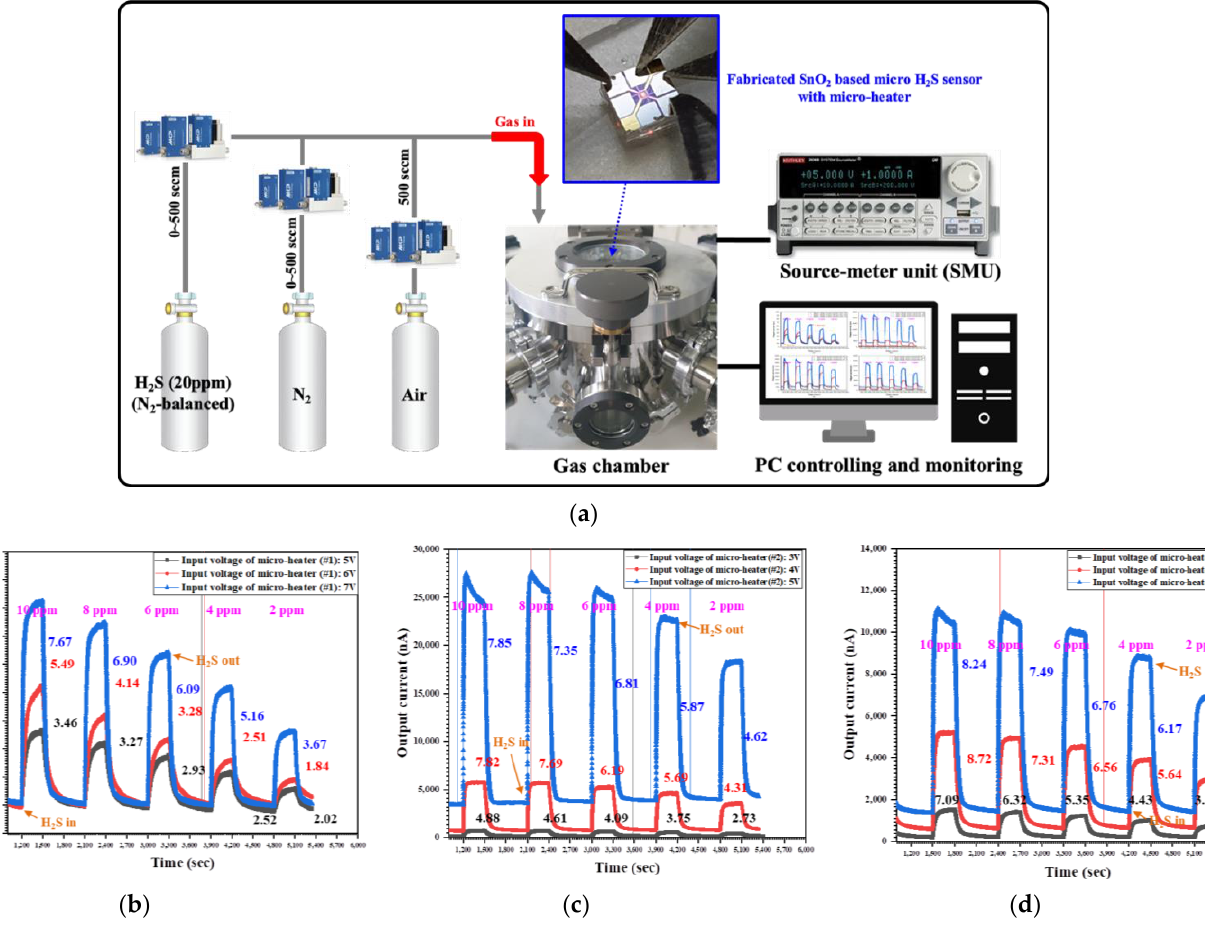
Figure 7. ( a ) Experimental setup for characterization of SnO 2 -based H 2 S microsensor with micro-heaters of different geometric designs, and measured output currents of SnO 2 -based H 2 S microsensor with micro-heaters of ( b ) type #1, ( c ) type #2, and ( d ) type #3 as a function of H 2 S